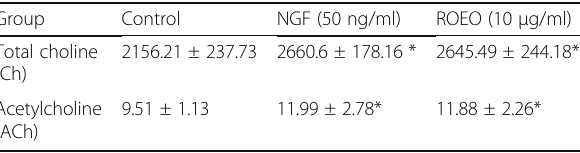
Table 3 Intracellular acetylcholine (ACh) and choline (Ch) level in PC12 cells (ng/mg) a